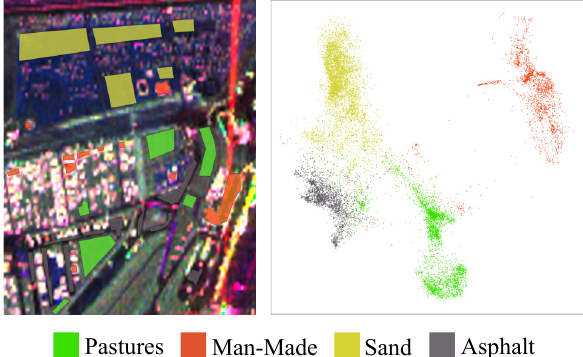
Figure 2. Embedding unknown test data in previously learned feature space. On the left the Pauli decomposition of the test scene overlaid with reference polygons is shown. On the right, the 2D embedding of test data is presented.